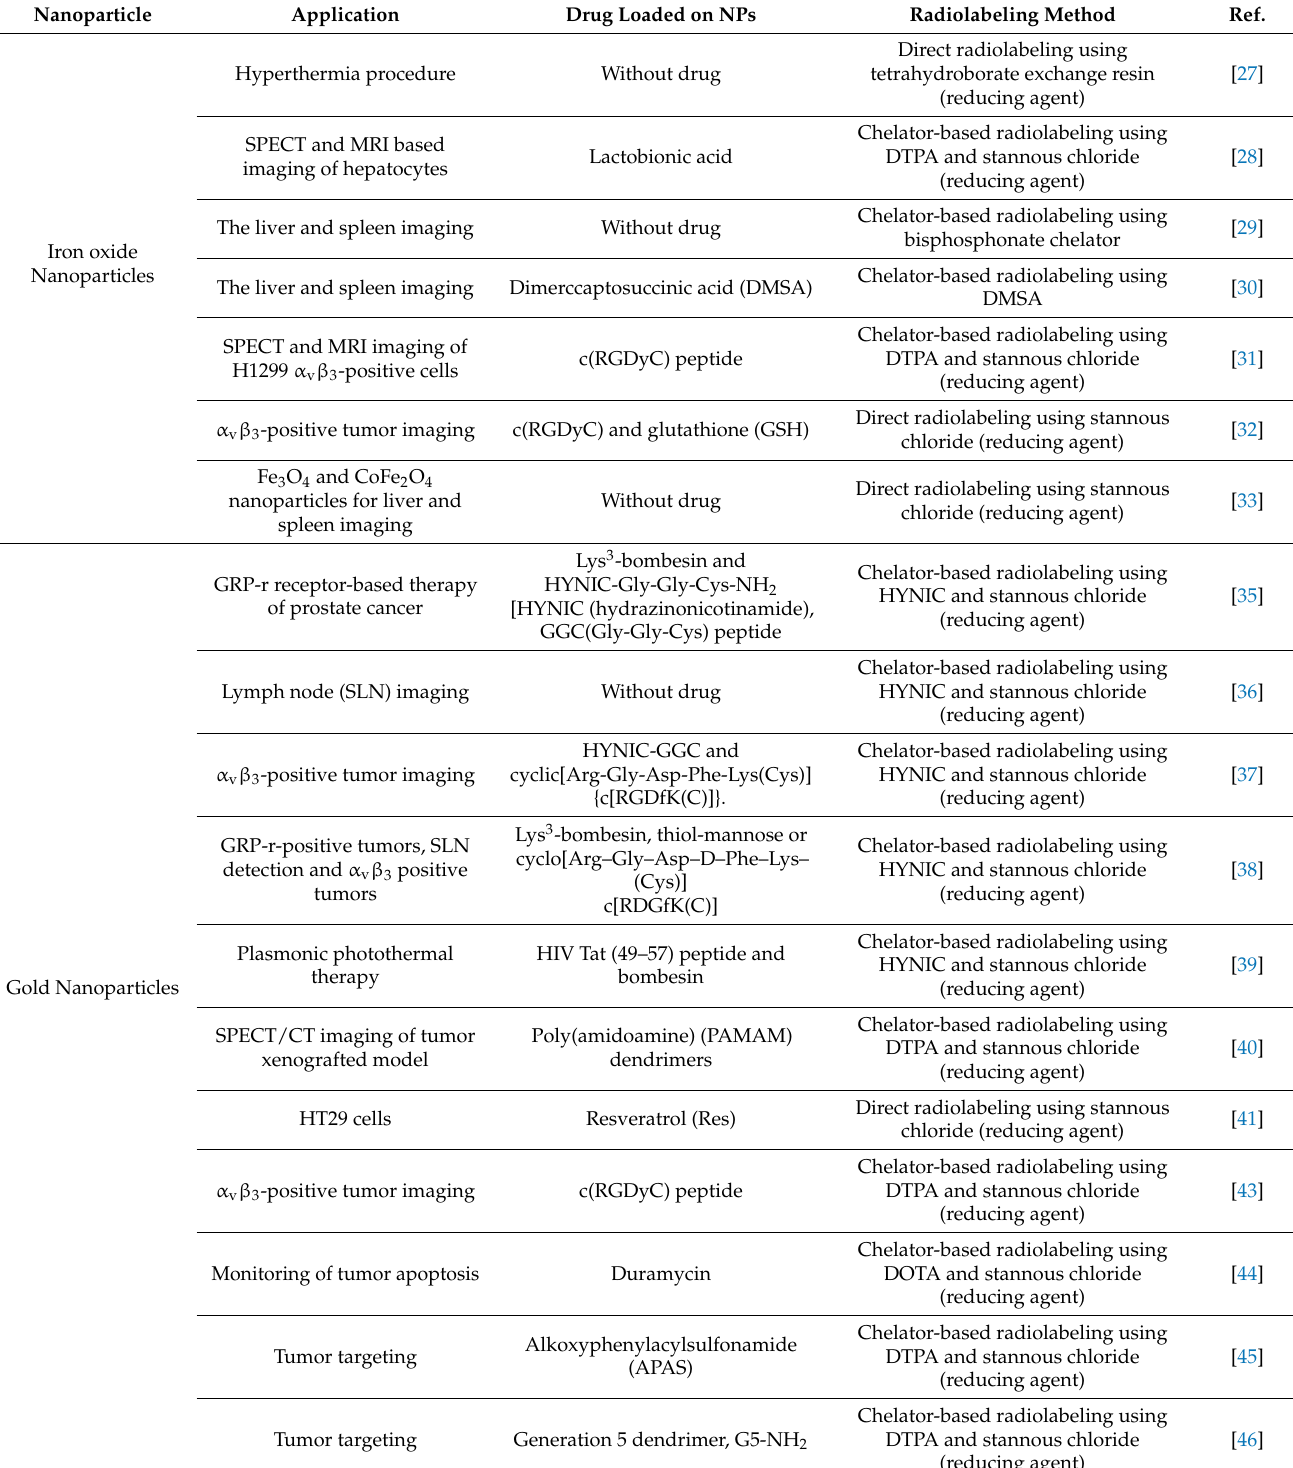
Table 2. Summary of 99m Tc labeled inorganic nanoparticles and their